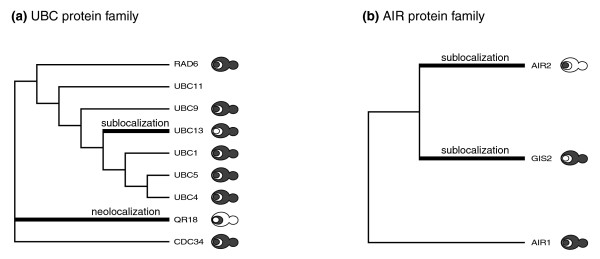
Subcellular localizations of the (a) UBC and (b) AIR family members and subcellular localization changes inferred based on the phylogeny. The common name and yeast protein identifier (in brackets) of the protein are indicated. The schematic representation of a yeast cell depicts three possible localizations: nucleus (small circle), endoplasmatic reticulum (eclipse around nucleus), and cytoplasm (remainder of the cell). The co-localization of the protein with one of the yeast subcellular compartments is indicated by grey shading.